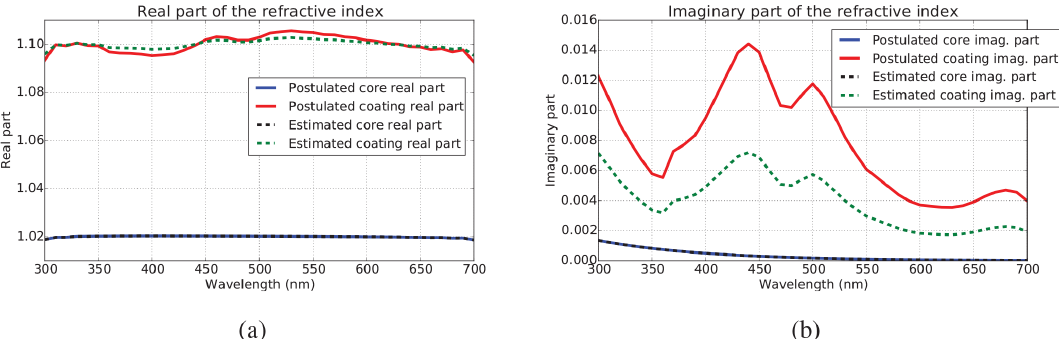
Figure 12. Postulated and estimated (a) real and (b) imaginary parts of the refractive indices for the inner and outer layers of spherical-shaped coated particles using the Bernard model.